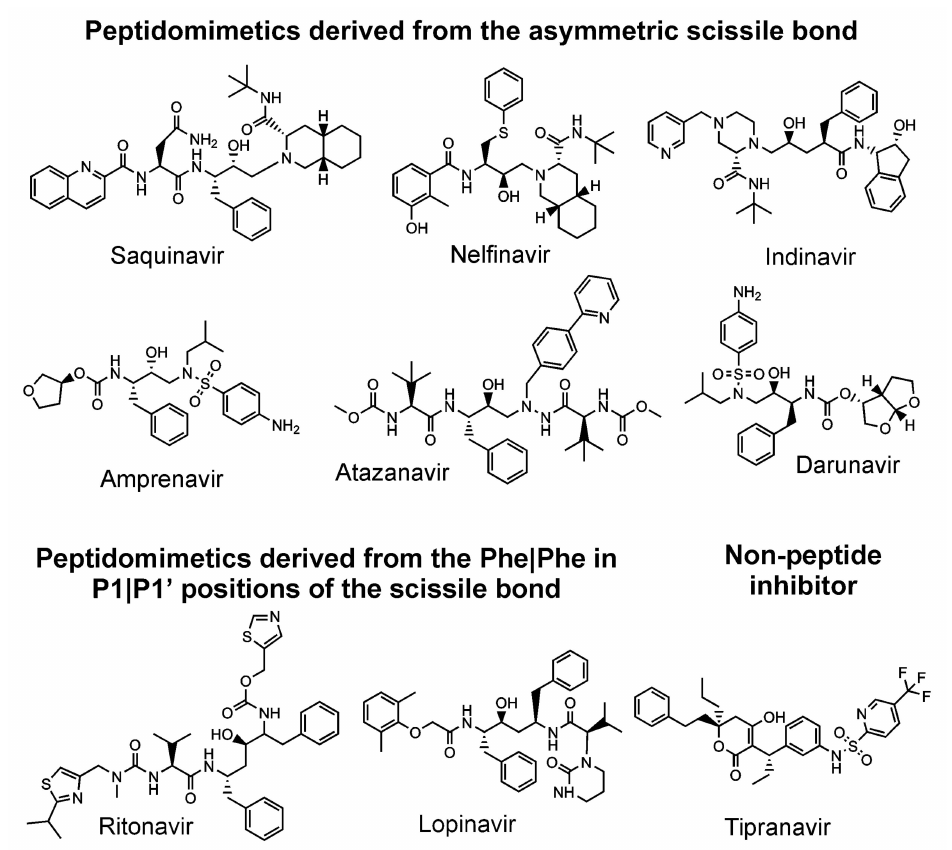
Figure 3. FDA-approved inhibitors of the HIV